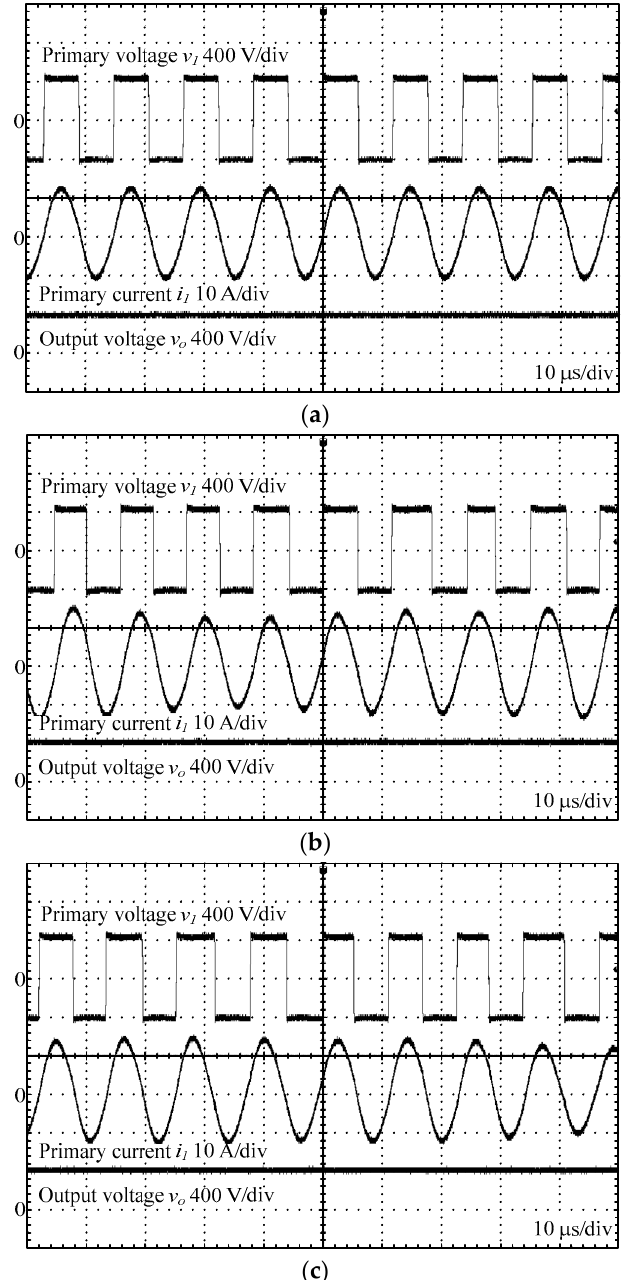
Figure 7. Operation waveforms with SS compensation: ( a ) is the constant frequency operation, ( b ) is the spread spectrum with a uniform distribution (SSUD), and ( c ) is the spread spectrum with a biased distribution (SSBD).